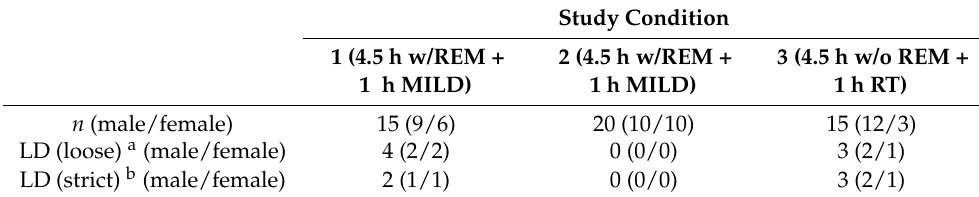
Table 2. Number and type of lucid dreams in the three experiments.